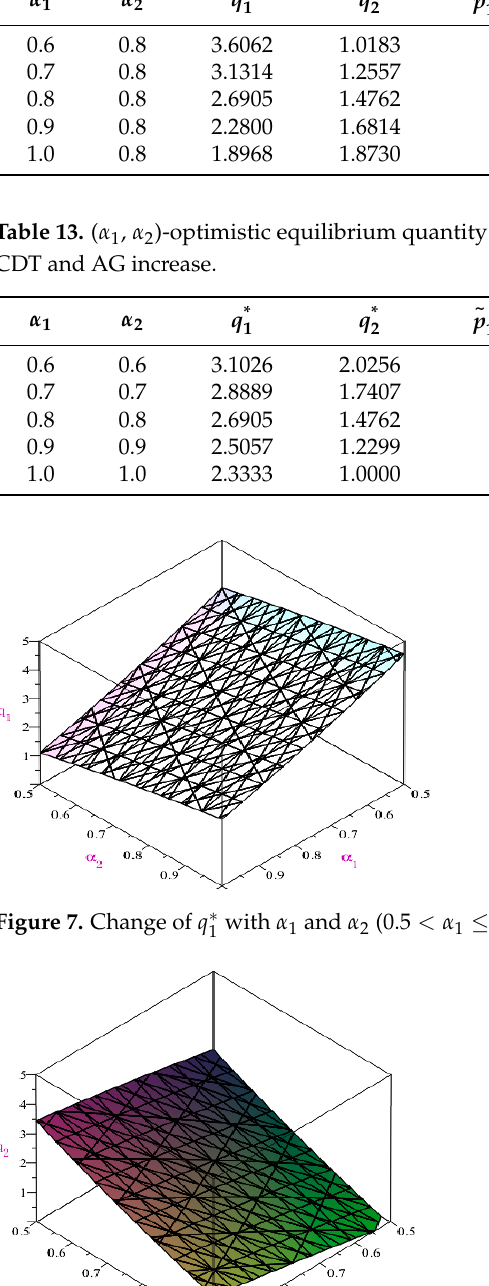
Figure 8. Change of * 2 q with α 1 and α 2 (